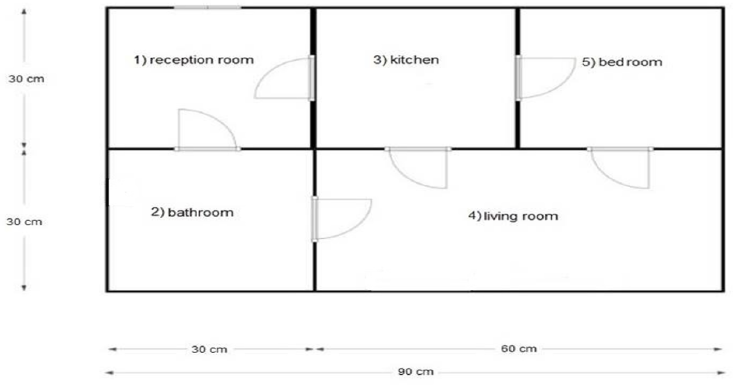
Figure 1. Blue print of the experiment